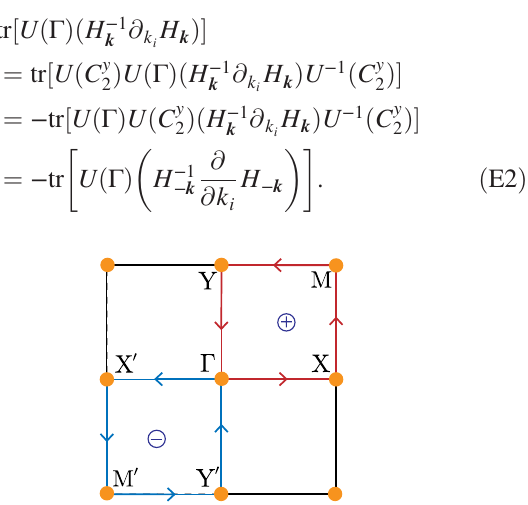
FIG. 20. Illustration of the interval of integral in the winding number. Note that the path colored by blue is symmetry related to the red path. Here, white solid circles denote gapless points, and (cid:3) represent the sign of the winding